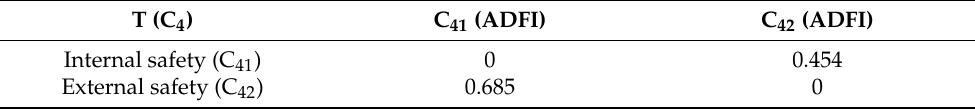
Table 9. Average direct fuzzy influence matrix T between Safety (C 4 ) sub-criterions.